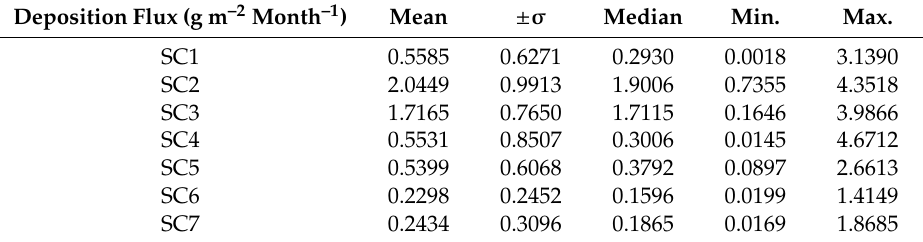
Table 4. Statistical characteristics of the calculated deposition flux.